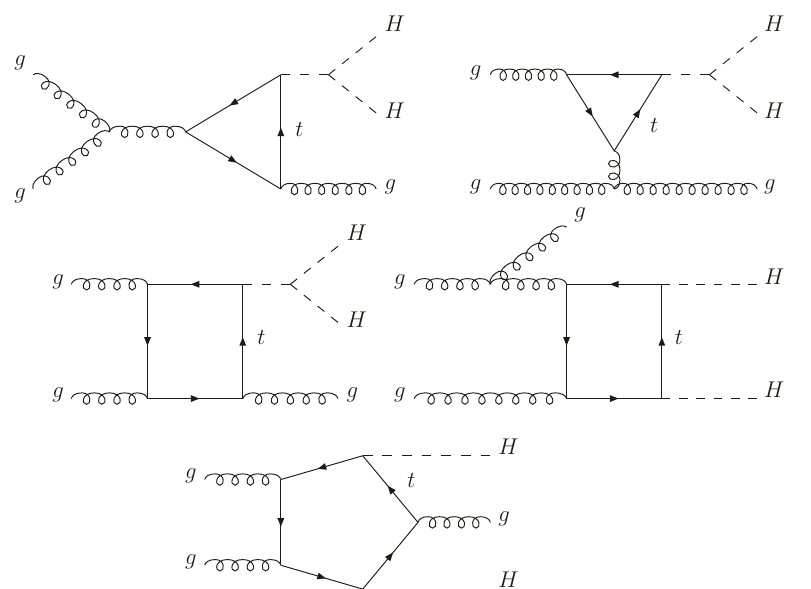
Figure 8 . Typical one-loop triangle (upper row), box (middle row), and pentagon (lower row) diagrams for the partonic channel gg HHg contributing to the real corrections of Higgs-pair ! production via gluon fusion at NLO in QCD.